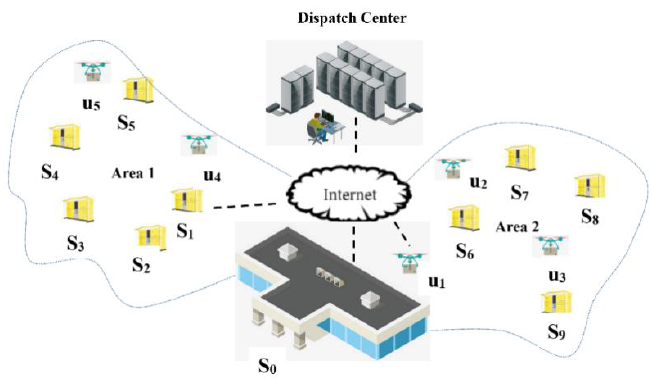
Figure 2. The execution process of the delivery system.